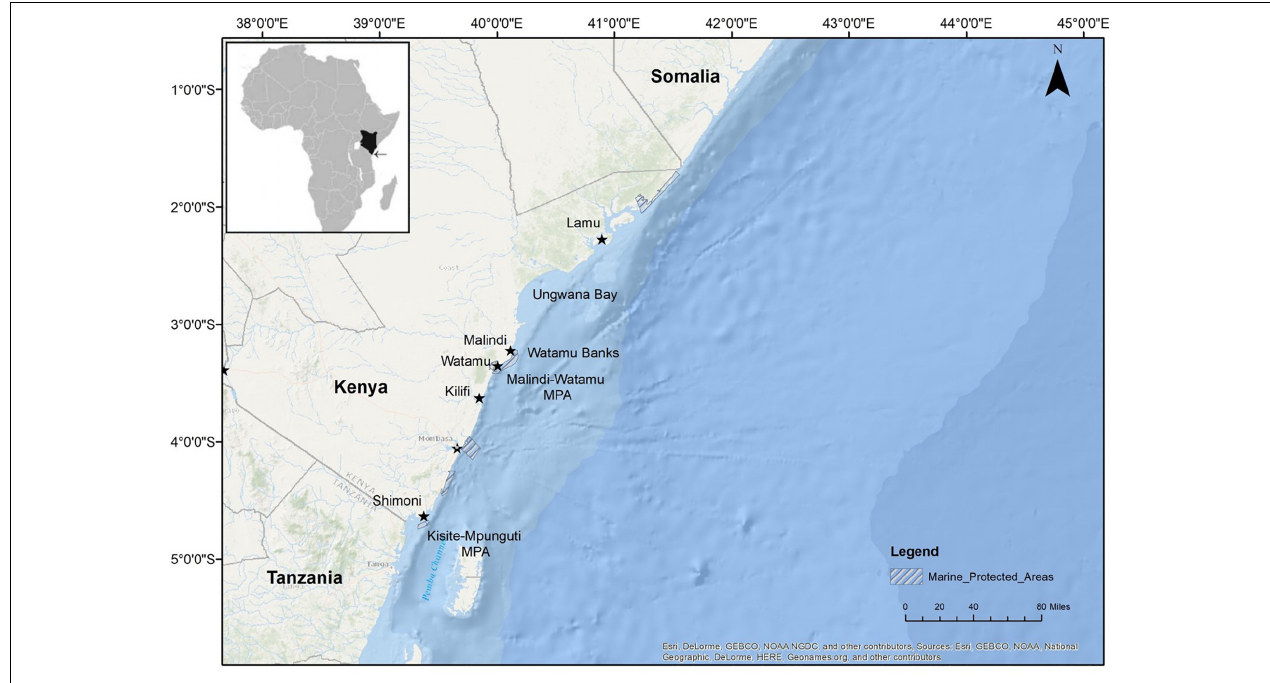
FIGURE 1 | Map of the Kenyan